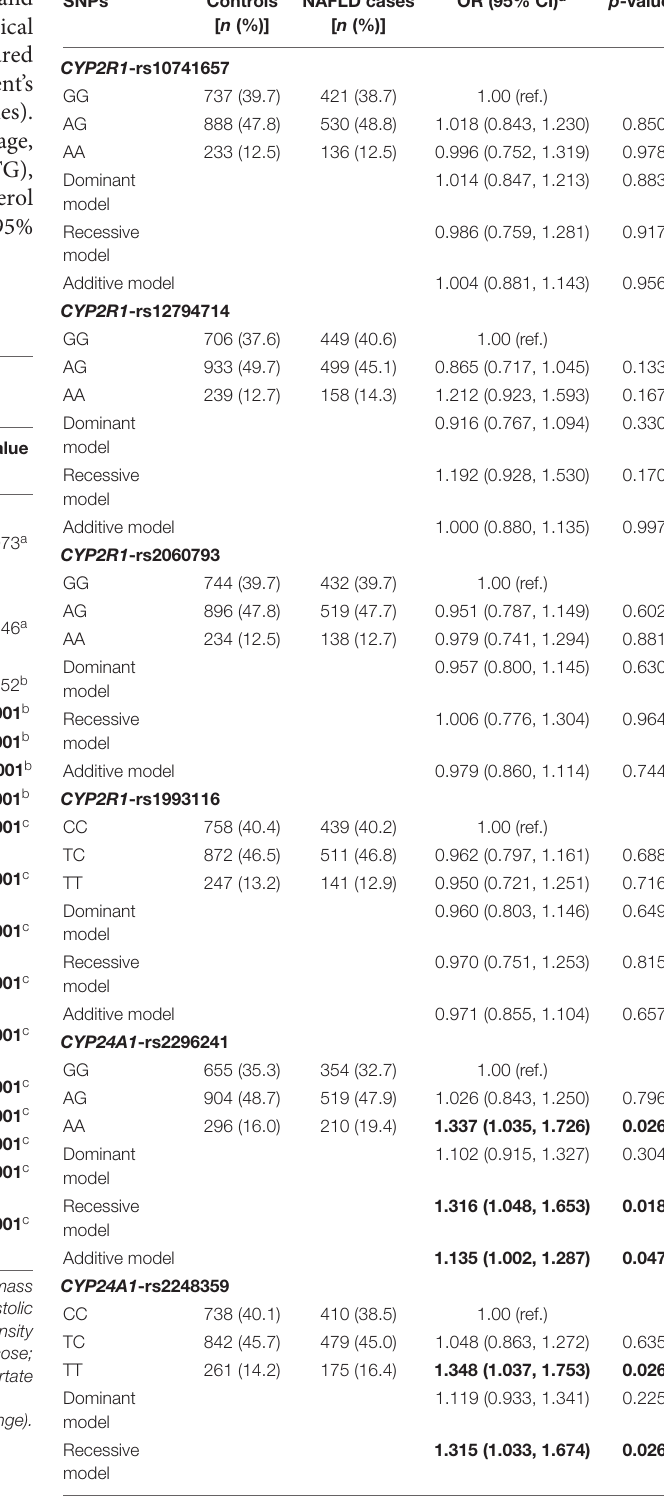
TABLE 2 | Genotype distributions among the two study groups and association analyses of these 11 SNPs and